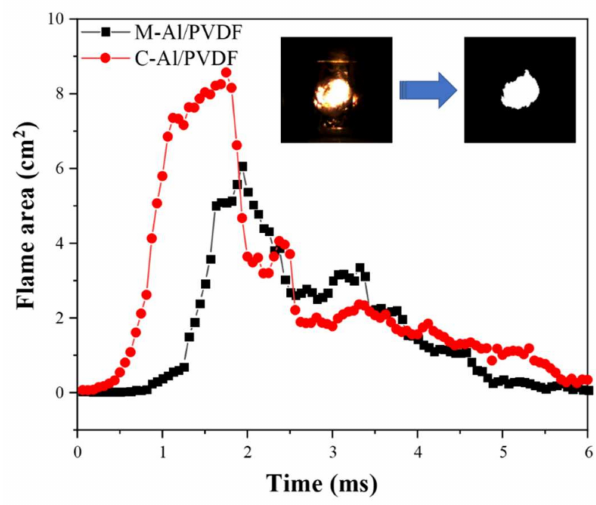
Figure 7. The curve of flame area versus time for samples M-Al/PVDF and